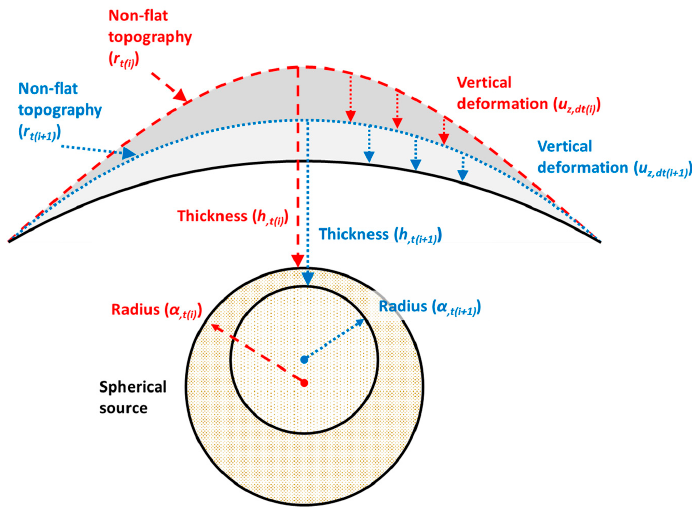
Figure 8. Schematic drawing of surface deformation in consecutive periods and corresponding ice thicknesses, defined as the difference between depth and radius of a spherical pressure source.